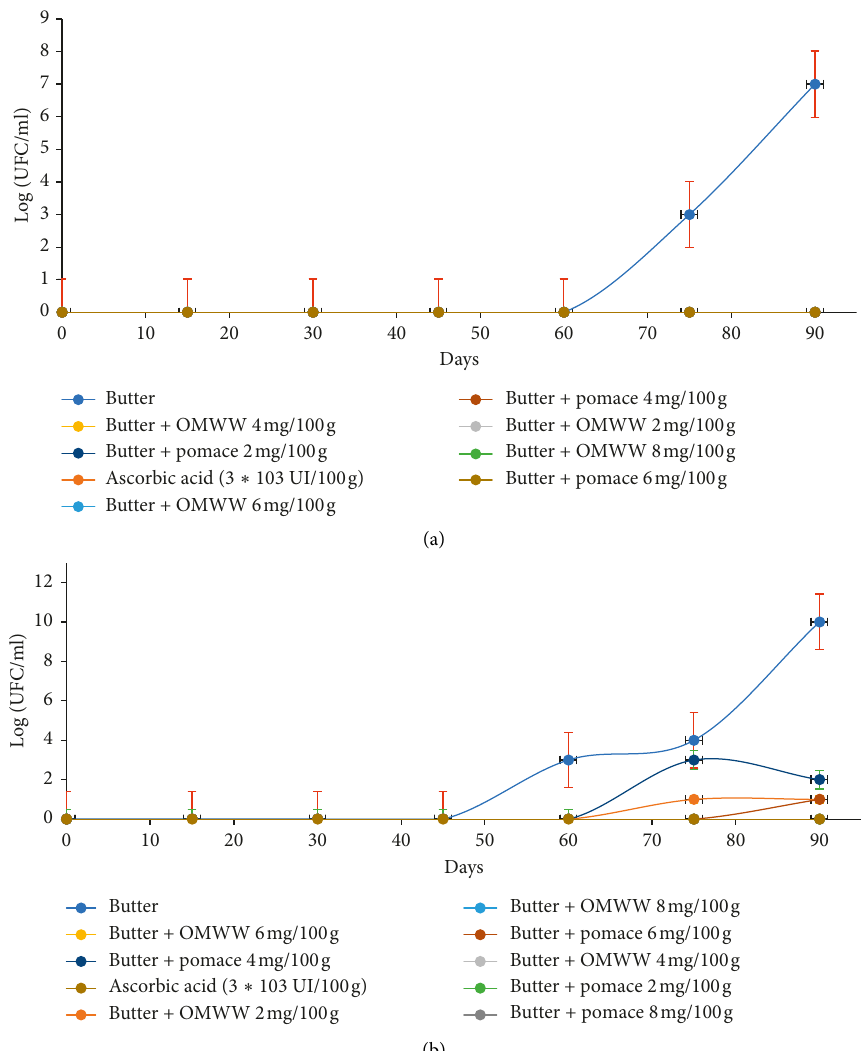
Figure 9: Evolution of total butter coliform populations as a function of time. (a) Samples stored at 25 ° C. (b) Samples stored at 60 ° C.